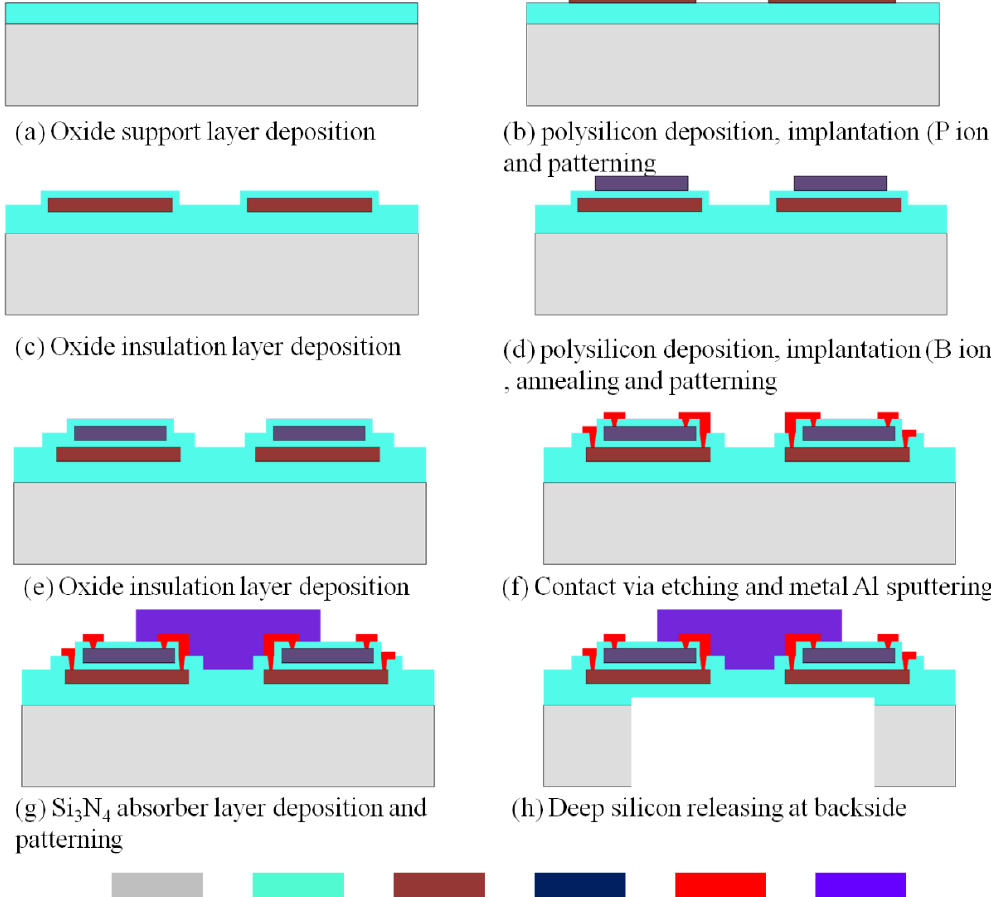
Figure 9. Schematic diagram of the thermopile fabrication process.